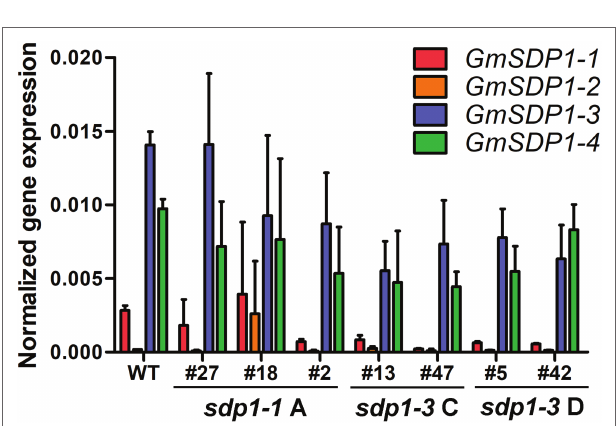
FIGURE 5 | GmSDP1 expression is suppressed in transgenic lines. GmSDP1 expression in R7 seeds was quantified using RT-qPCR with paralog-specific primers and normalized to the geometric mean of the reference genes ELF1B and SKIP16 . Values represent the mean expression values for seeds collected from two individual plants for each line.